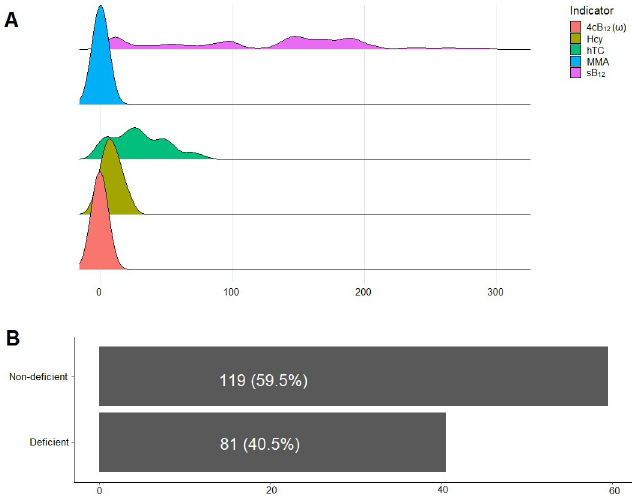
Fig 1. Distribution of vitamin B12 indicators and the prevalence of B12 deficiency. (A) Density plots of vitamin B12 indicators; (B) Bar graph displaying the prevalence of vitamin B12 deficiency using 4cB12. 4cB12 ( ω ): combined vitamin B12 indicator, Hcy: Homocysteine, hTC: holotranscobalamin, MMA-methylmelanoic acid, SB12-Serum vitamin B12.